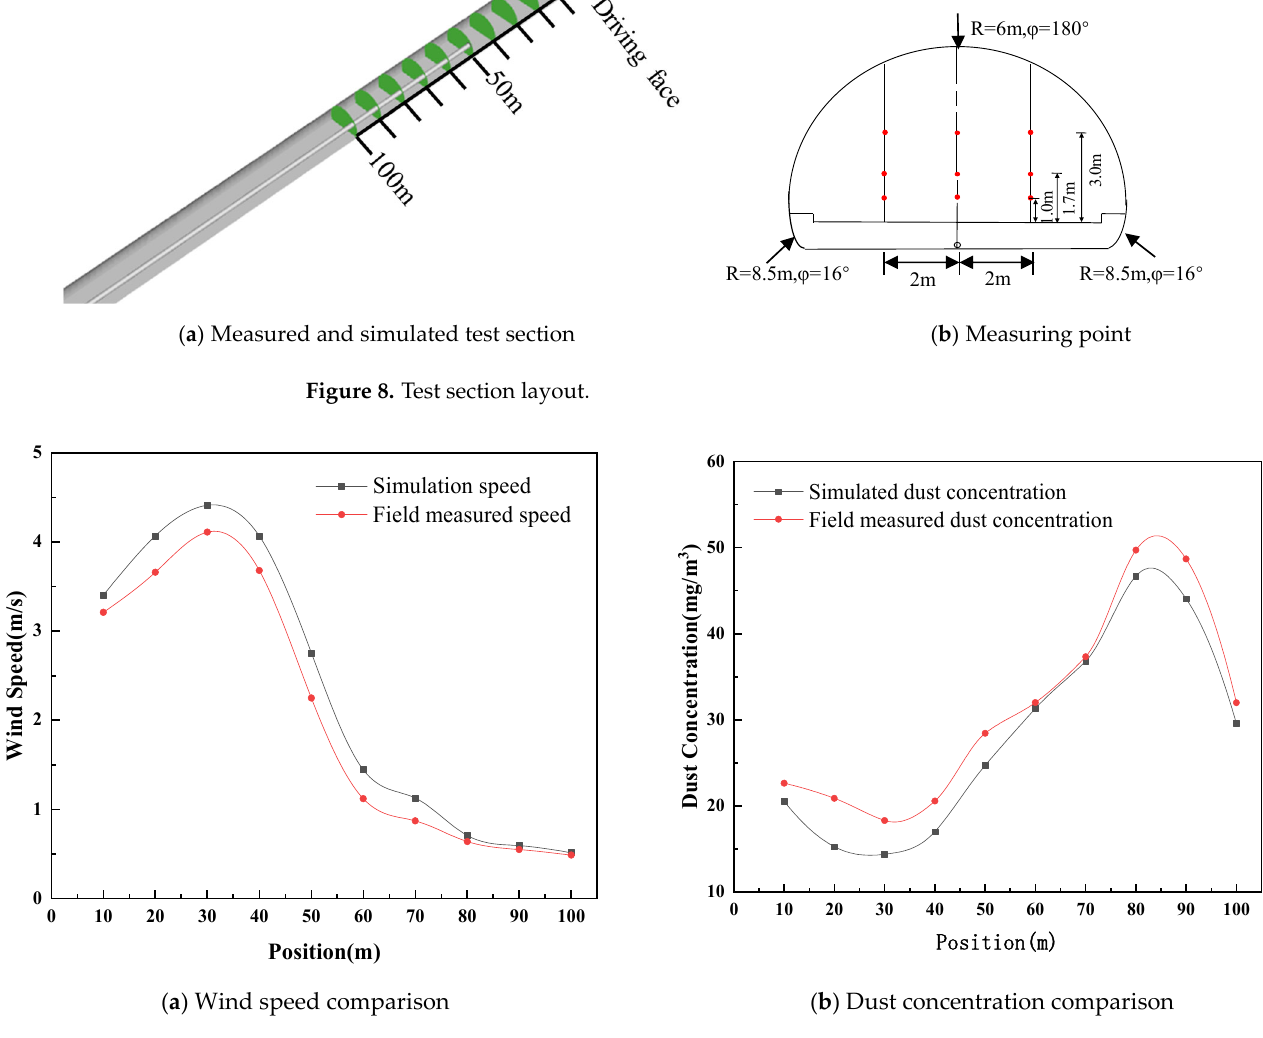
Figure 9. Comparison between the simulation result and field test.